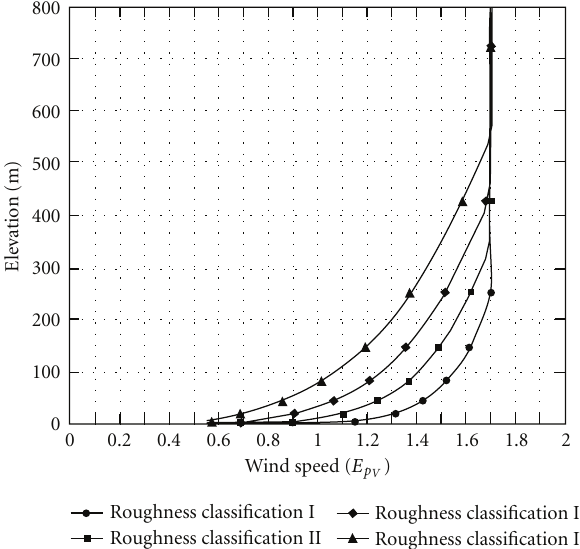
Figure 2: Vertical profiles of horizontal wind speed calculated from equations given in Bulletin no. 1454 of the Ministry of Construction, 2000.